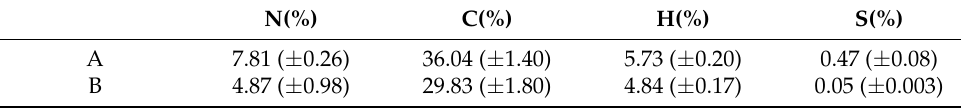
Table 2. Elemental analysis of N(%), C(%), H(%) and